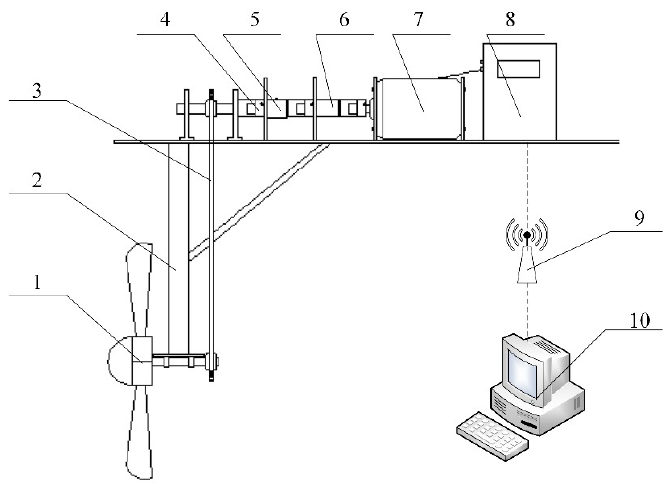
Figure 3. Schematic diagram of turbine performance evaluation device. 1. The turbine under test; 2. Support frame; 3. Chain drive; 4. Coupling; 5. Torque sensor; 6. Speed increaser; 7. Servo motor; 8. Evaluation control box; 9. Wireless transmission; 10. PC terminal.